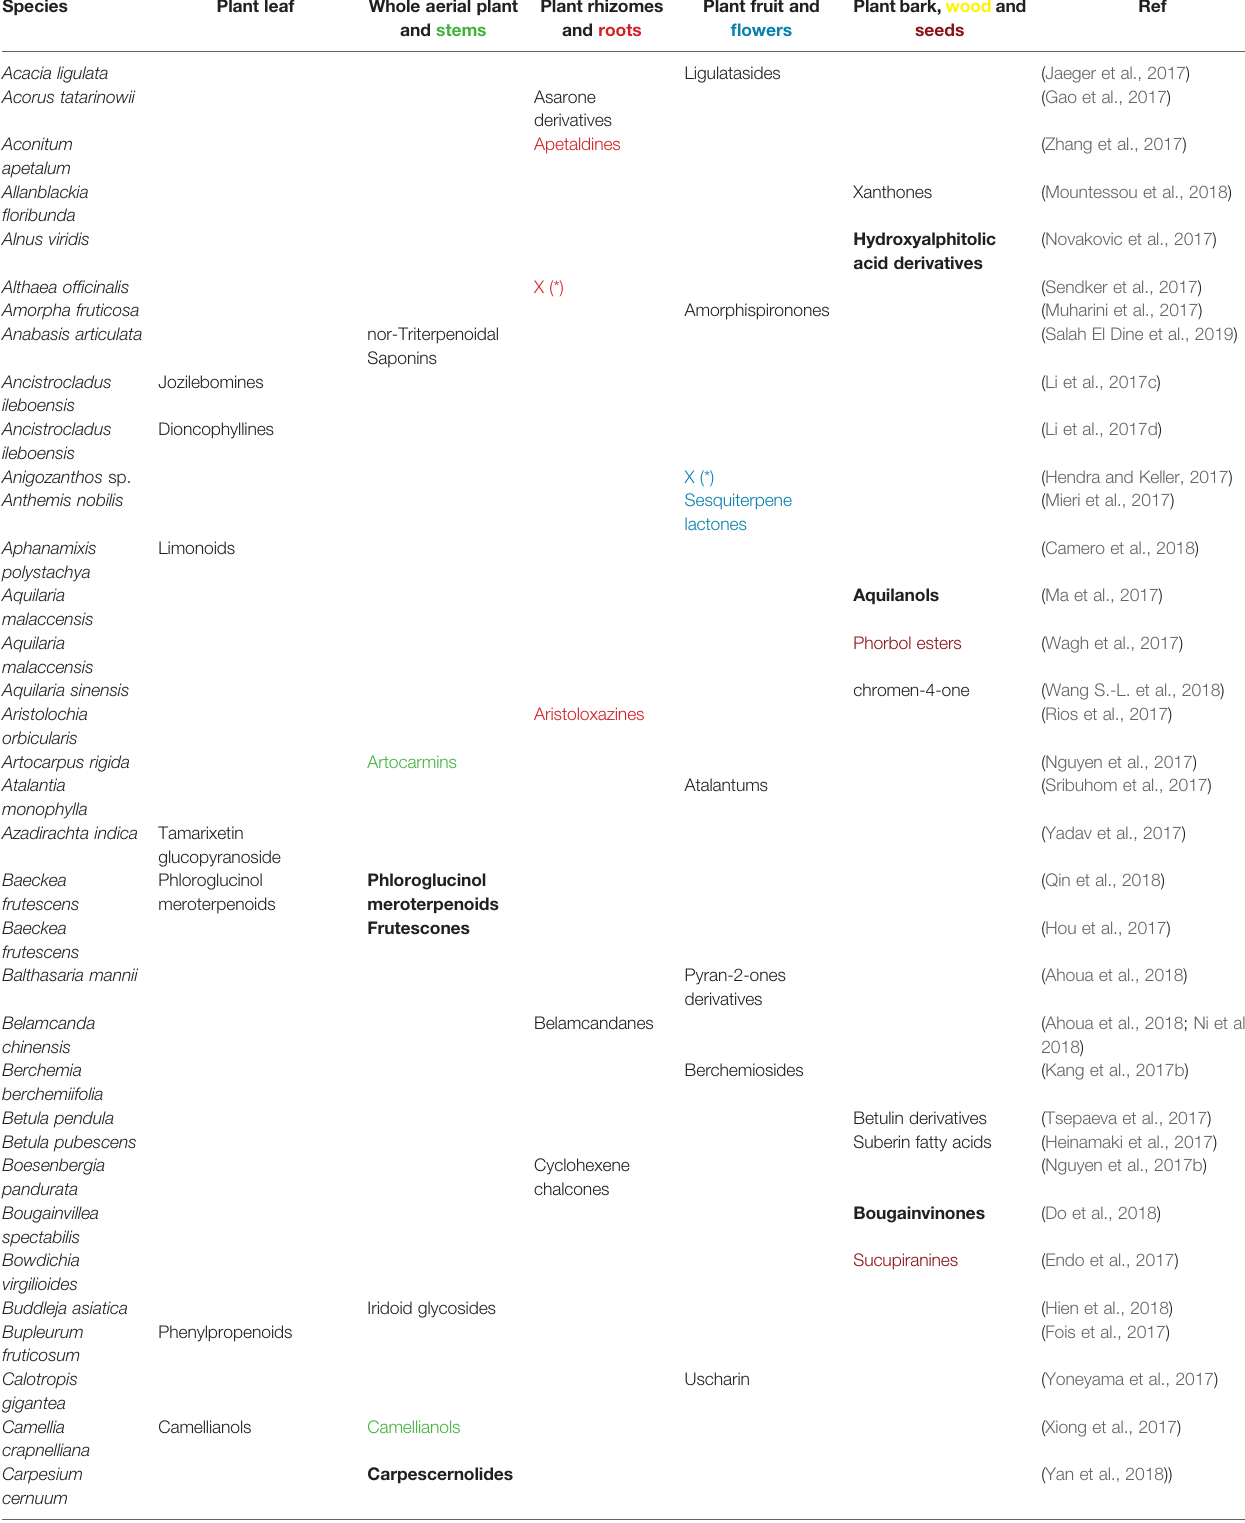
TABLE 4 | Compounds from plant